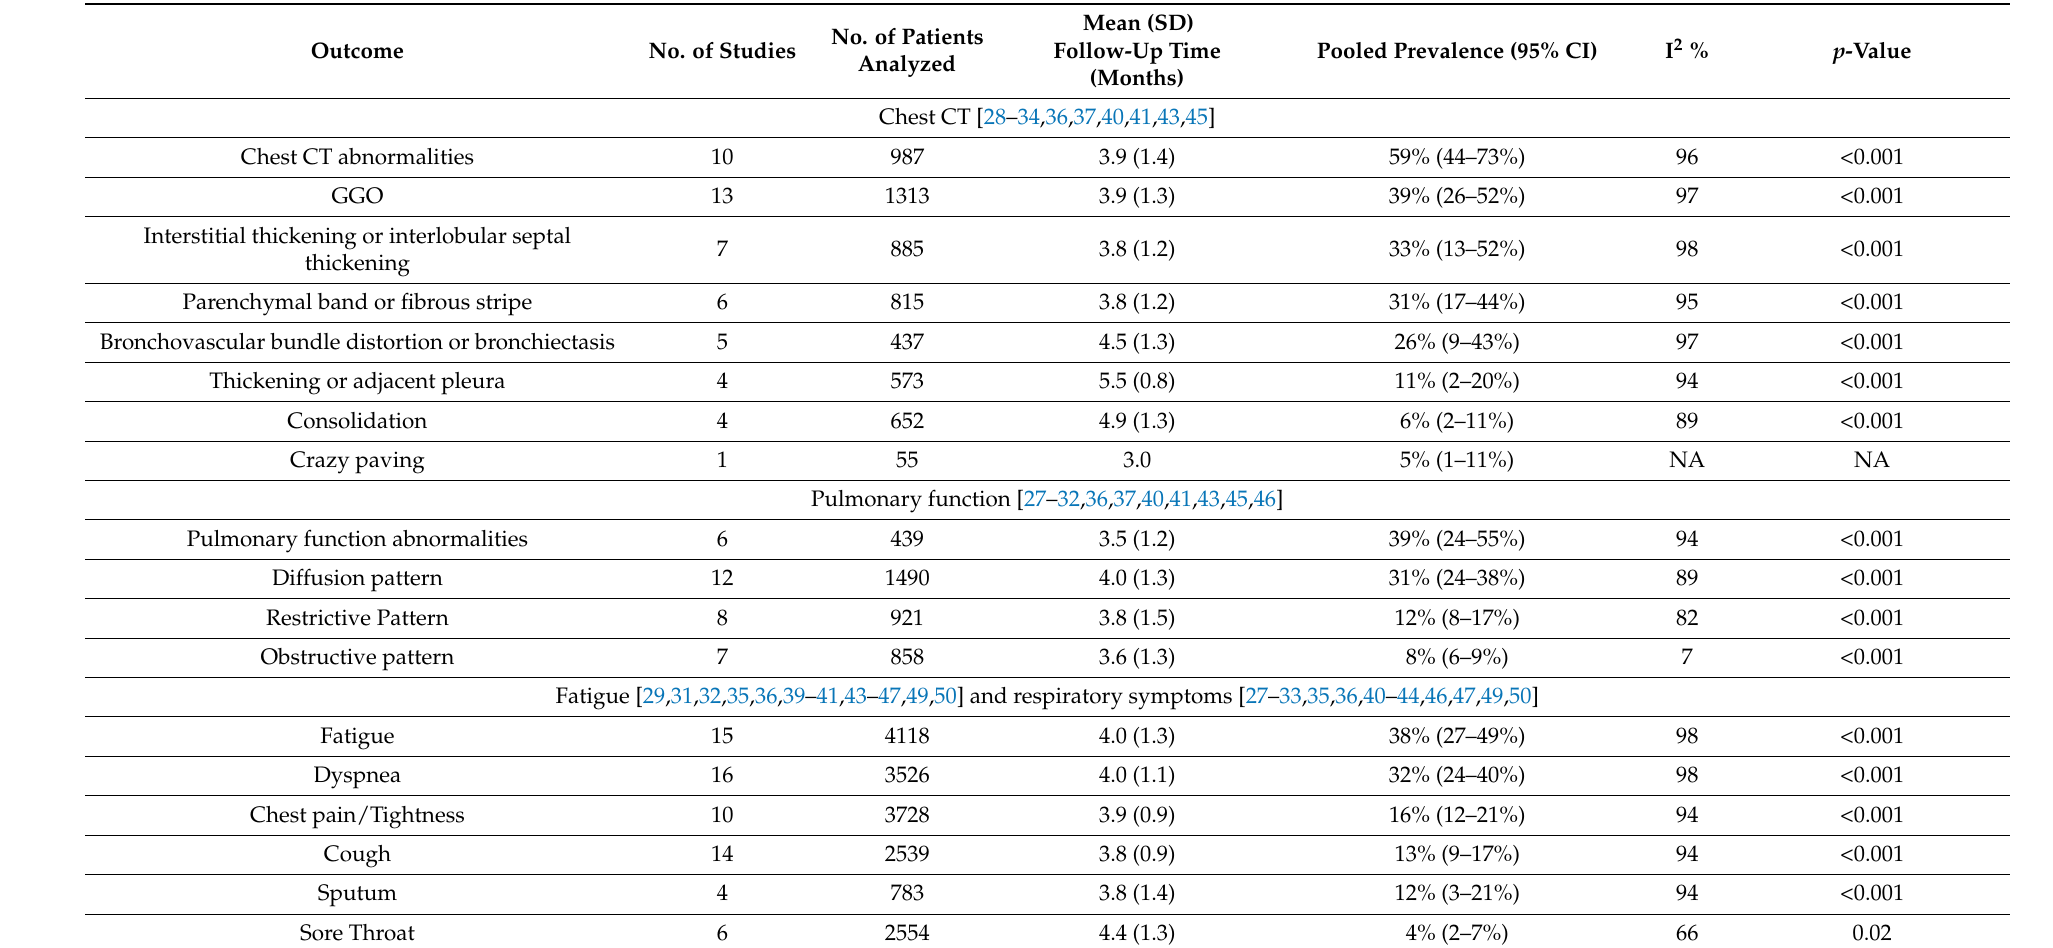
Table 2. Prevalence of persistent COVID-19 effects at 3 to 6 moths